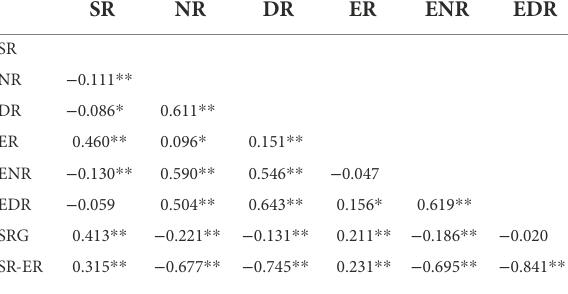
TABLE 10 Correlations between the Self-Regulation General (SRG) construct and the types of self-regulation and external regulation (SR-ER; n = 422).